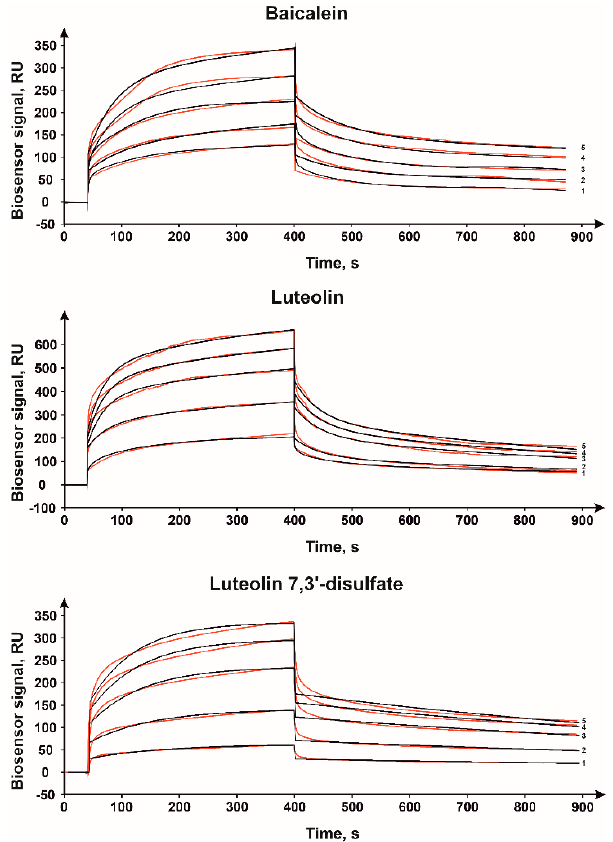
Figure 2. Typical surface plasmon resonance sensorgrams of binding between immobilized CYP51A1 on the optical chip and baicalein, luteolin and luteolin 7,3 ′ -disulfate at different concentrations: 10 (1), 25 (2), 50 (3), 75 (4) and 100 μ M (5). Fitting curves (theoretical models) are highlighted in black; Chi 2 = 25.3 (baicalein), 68.2 (luteolin), 10.2 (luteolin 7,3 ′ -disulfate).